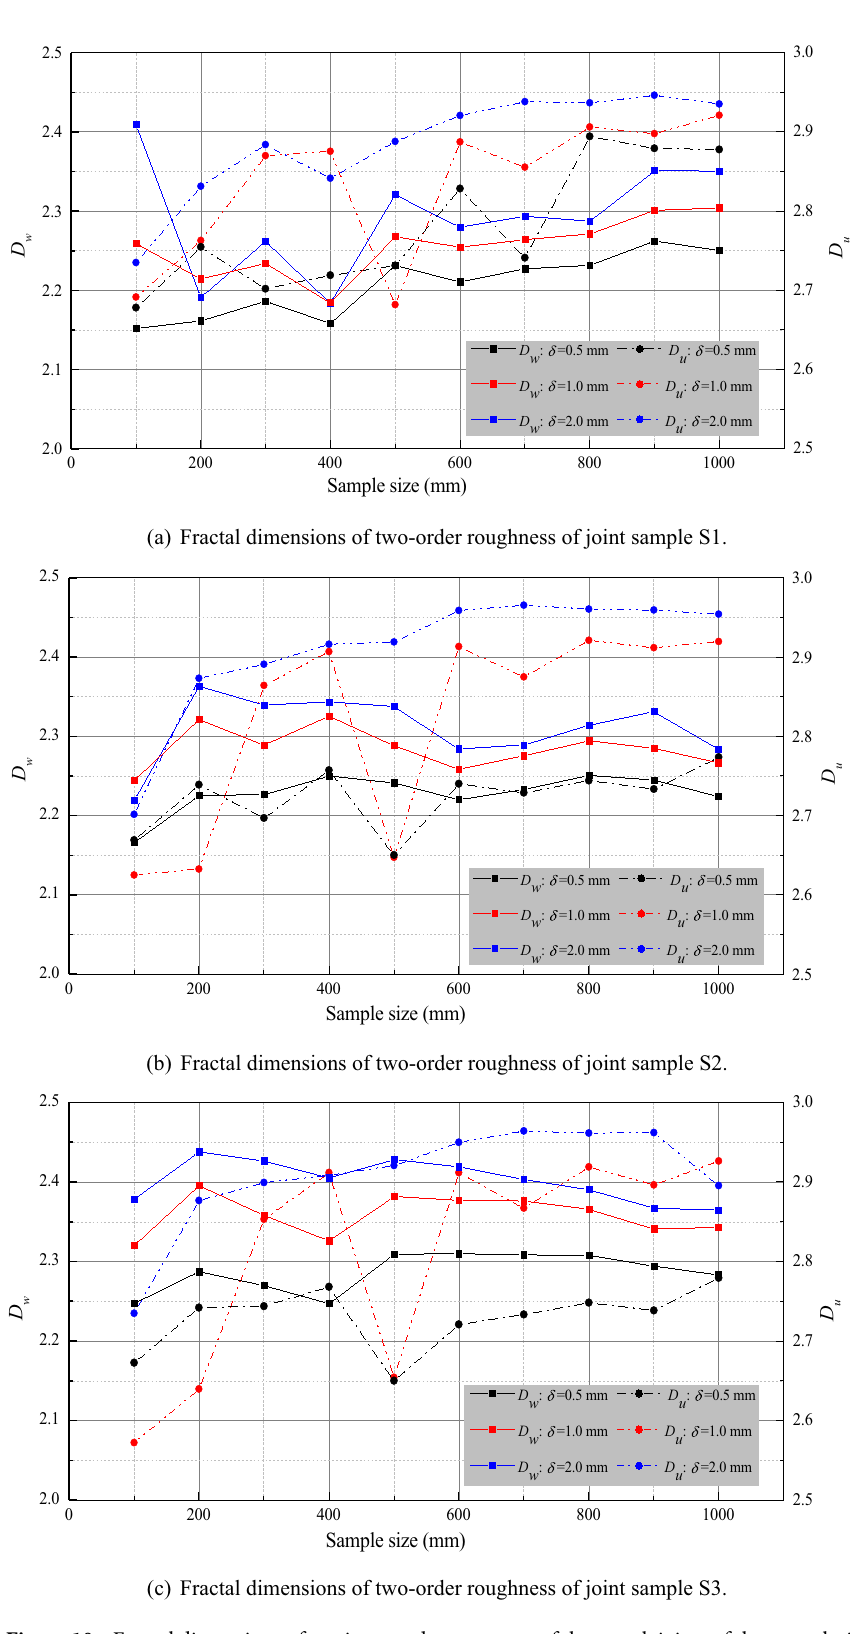
Figure 10. Fractal dimensions of waviness and unevenness of three rock joints of three resolutions at varying sample sizes. D w and D u are fractal dimensions of waviness and unevenness, respectively. δ denotes the